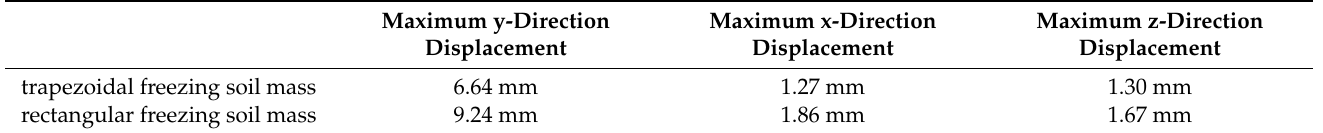
Table 4. Displacement of the tunnel portal with trapezoidal freezing soil mass or rectangular freezing soil mass.